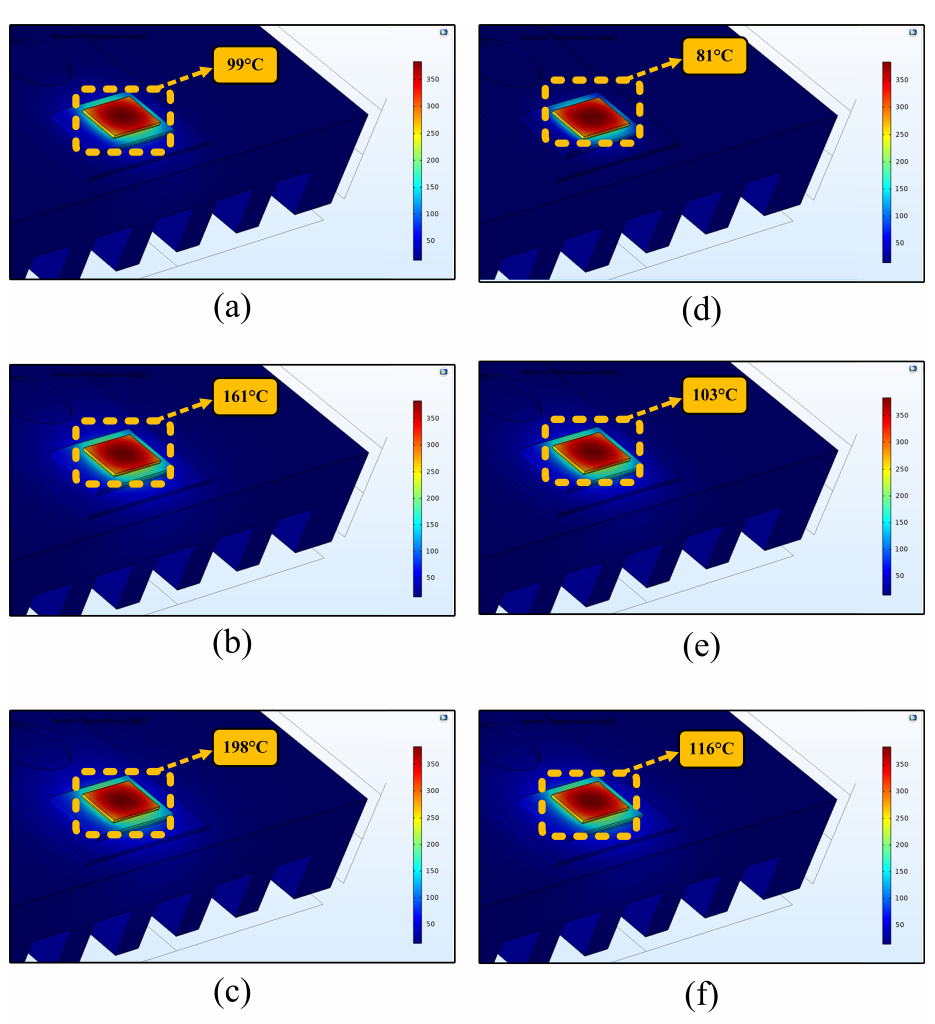
Figure 15. Thermal distribution of case study IGBT in condition 1 at ( a ) t = 1 µ s, ( b ) t = 4 µ s, ( c ) t = 7 µ s, and for condition 2 at ( d ) t = 1 µ s, ( e ) t = 4 µ s, ( f ) t = 7 µ